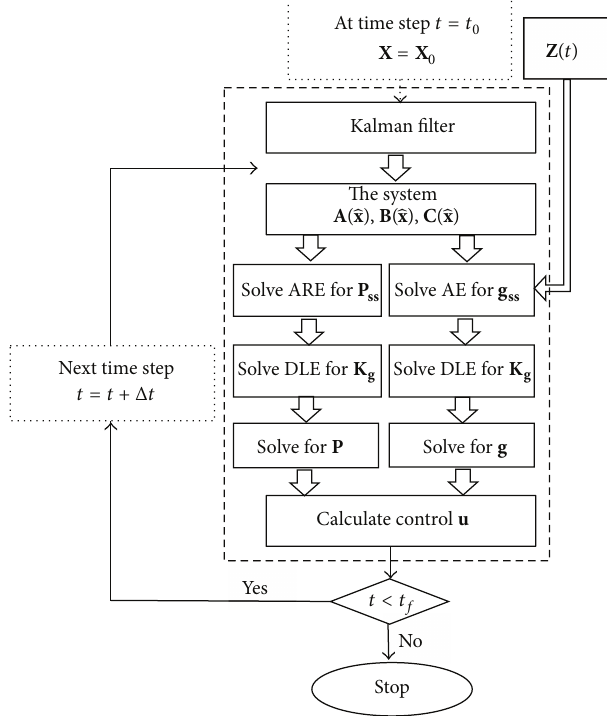
Figure 6: Flow chart of finite-horizon differential SDRE tracking technique for stochastic